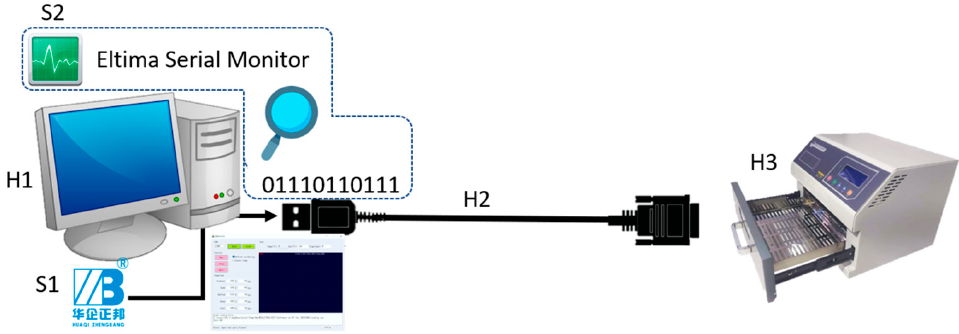
Figure 4. Experimental Setup. It consists of 2 pieces of Software (Labeled S1 and S2) and three pieces of hardware (Labeled H1, H2, and H3).